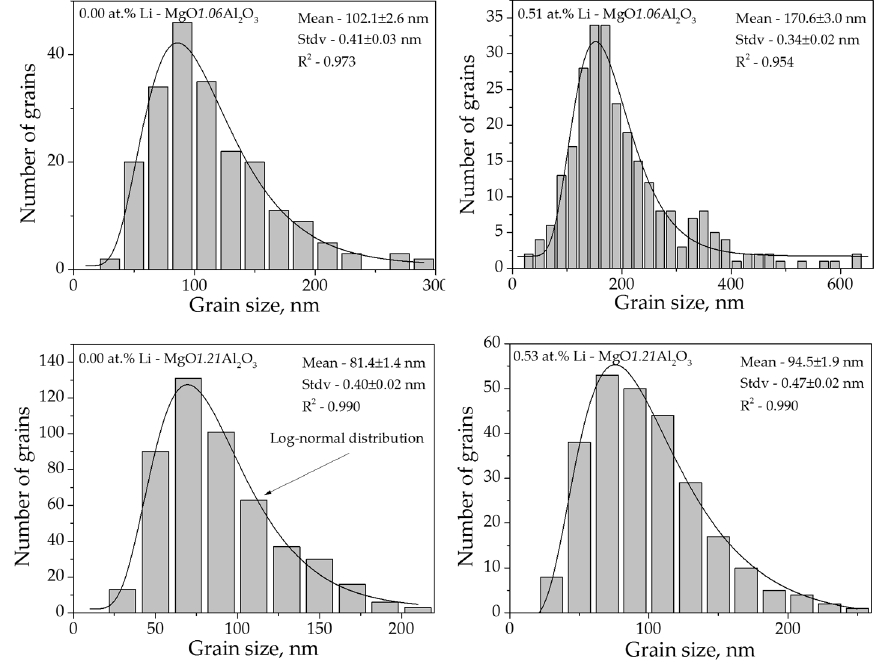
Figure 4. Typical grain size distribution and log-normal fitting of MgO·1.06Al 2 O 3 and MgO·1.21Al 2 O 3 with and without lithium addition processed by SPS.